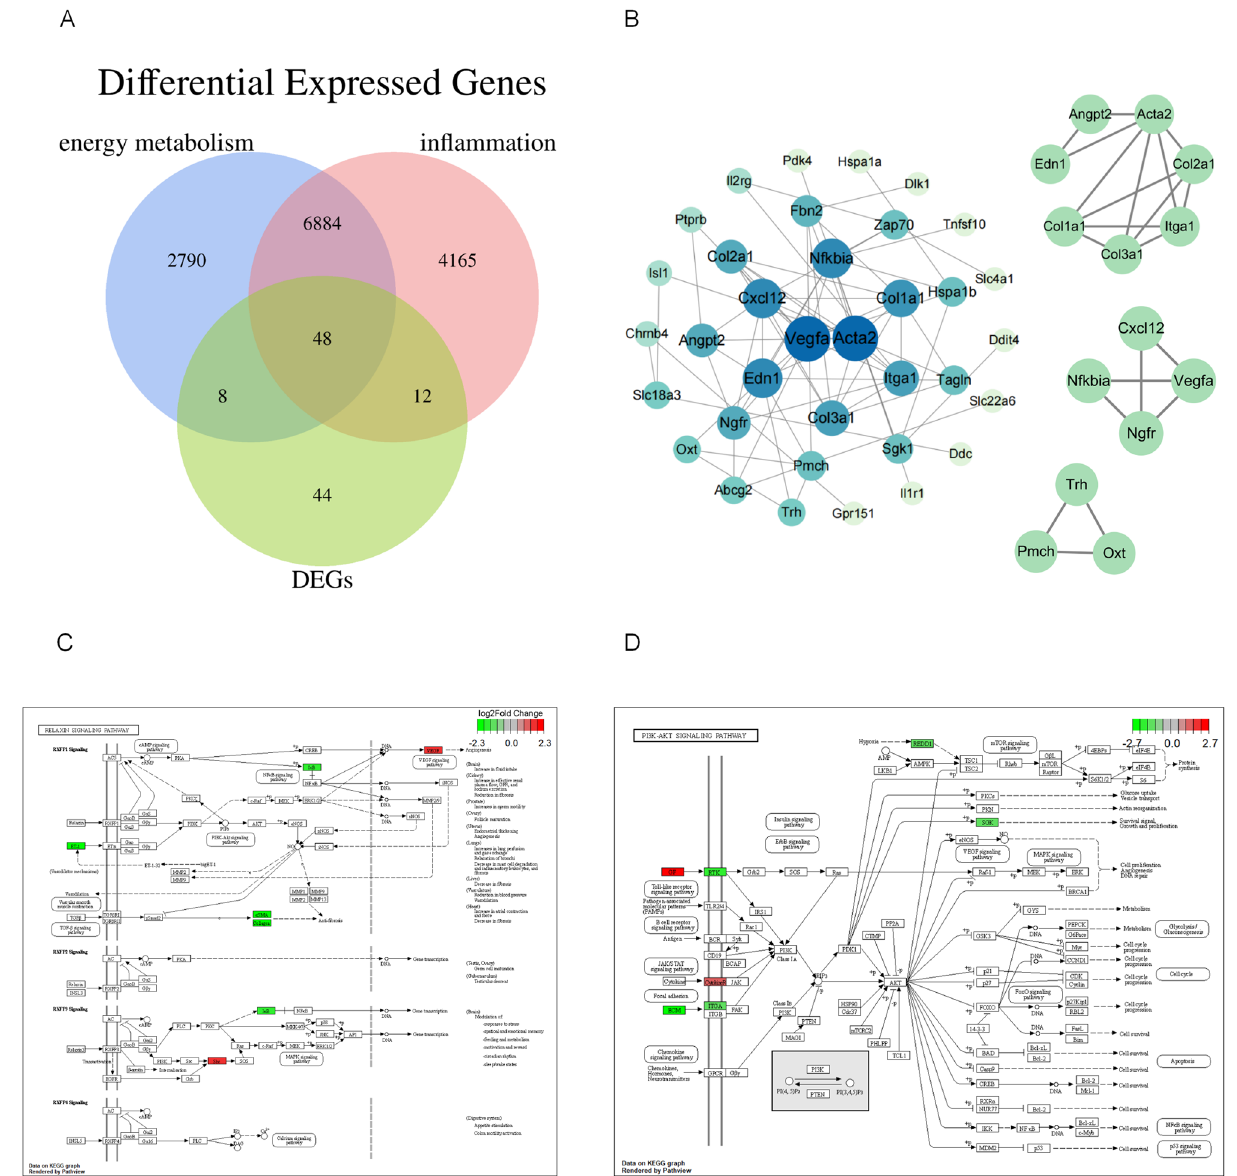
Figure 3. ( A ) Venn diagram of common differentially expressed genes (DEGs) between groups. The three circles represent energy metabolism-associated genes, inflammation-associated genes, and DEGs. The intersecting regions of the circles indicate the intersecting genes of different groups. ( B ) Proteins interacting with inflammation- and energy metabolism-associated genes. The protein–protein interaction network of DEGs was visualized using Cytoscape (version 3.9.1) according to its topological properties. The higher the color intensity and the lower the distance to the center, the more the number of genes it interacted with in the network. The hub sub-networks were screened by the MCODE plug-in. ( C ) Relaxin signaling pathway (www. kegg. jp/ entry/ map04 926). Red and green boxes represent DEGs that were significantly up or downregulated in this pathway, respectively. ( D ) PI3K-Akt signaling pathway (www. kegg. jp/ entry/ map04 151). Red and green boxes represent DEGs that were significantly up or downregulated in this pathway,